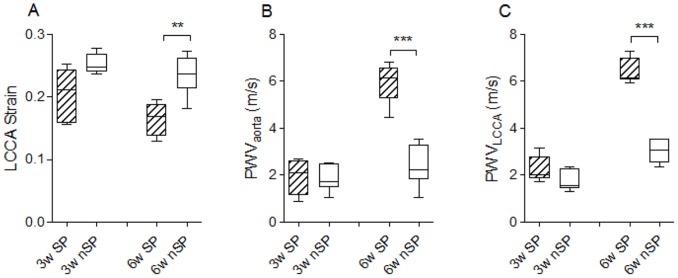
Arterial stiffness in stoke-prone (SP) and non stroke-prone (nSP) Dahl S female rats using pulse wave velocity (PWV) and arterial strain measured at three weeks and six weeks of age.Left common carotid arterial strain (A), aortic PWV (B) and left common carotid arterial PWV (C) were measured in SP and nSP Dahl S female rats at three weeks (3w) and six weeks (6w) of age. SP Dahl S females (3 weeks of age), n = 5; nSP Dahl S females (3 weeks of age), n = 6; SP Dahl S females (6 weeks of age), n = 5; nSP Dahl S females (6 weeks of age), n = 6. Values are presented as box-and-whisker plots with the ends of the whiskers representing the minimum and maximum of all of the data. **P<0.01, ***P<0.001 (One Way ANOVA followed by Holm-Sidak Test for multiple comparisons).